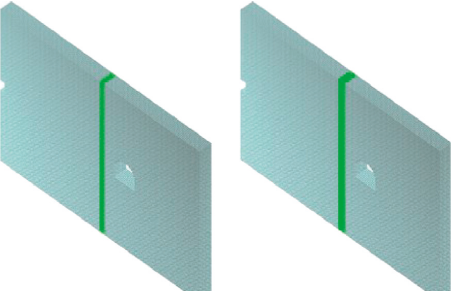
Figure 11: Schematic diagram of the model when the width of discontinuity is 2m or 3m, respectively.